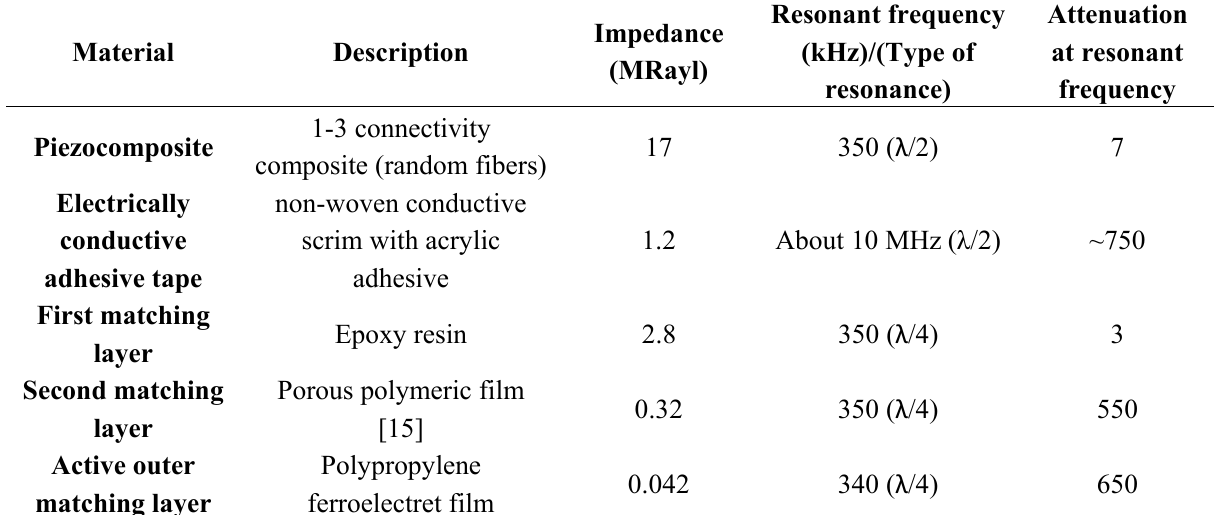
Table 1. Summary of materials